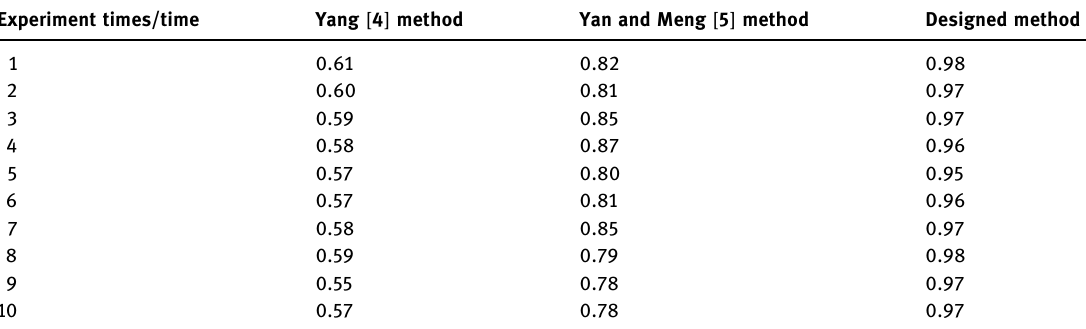
Table 2: Comparison of accuracy of three risk assessment methods Experiment